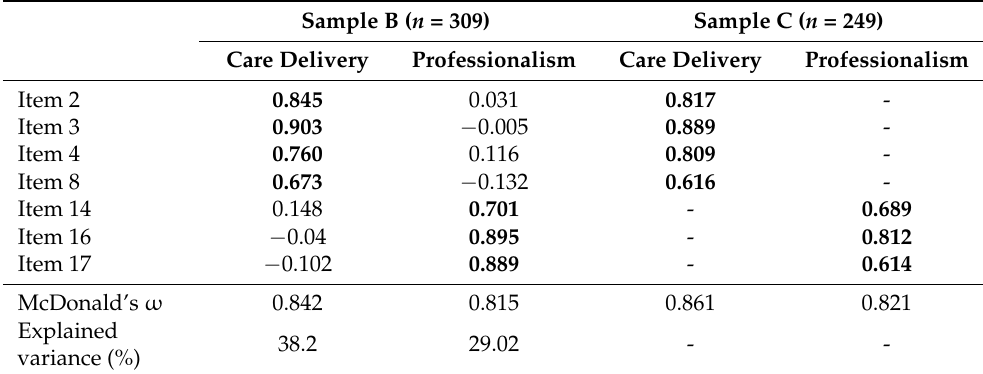
Table 3. Factor loadings of the EFA performed in Sample B and CFA conducted in Sample